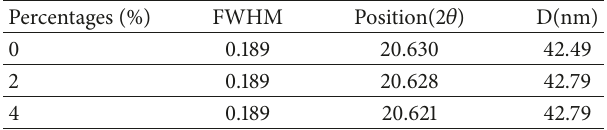
Table 3: The size of the crystallite according to percentage of europium.